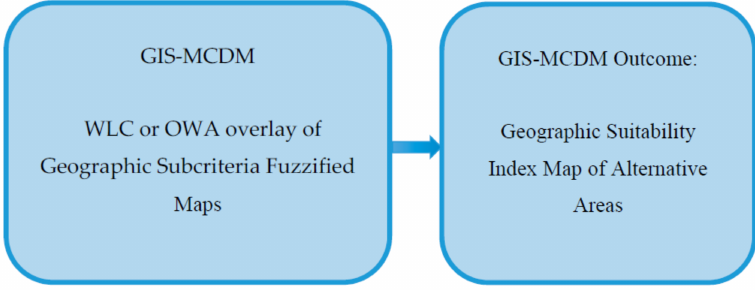
Figure 2. GIS-multi-criteria decision-making (MCDM) methodology.